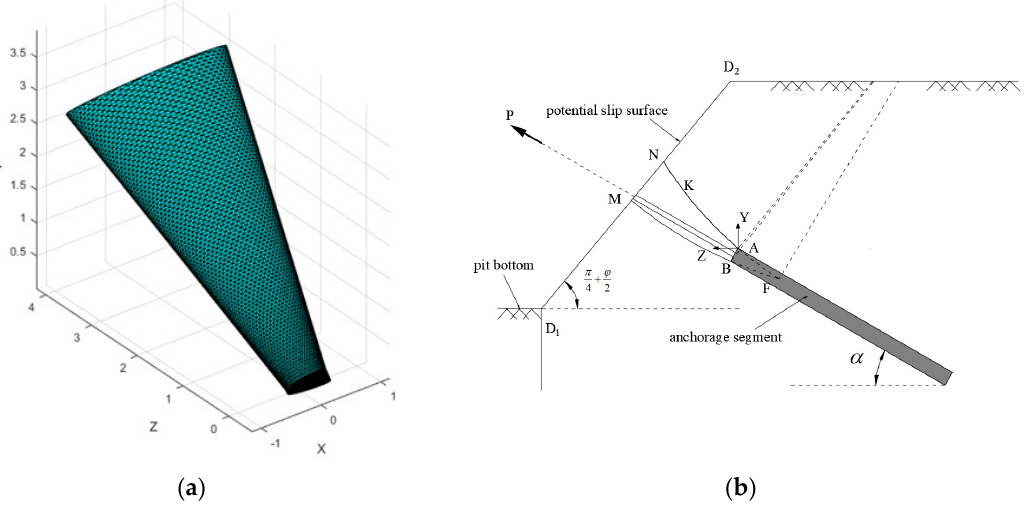
Figure 12. Velocity discontinuity surface: ( a ) 3D model diagram; ( b ) cross-sectional diagram.